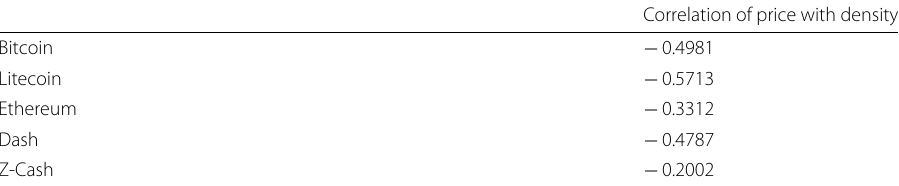
Table 3 Correlation of price with density of MTG graph